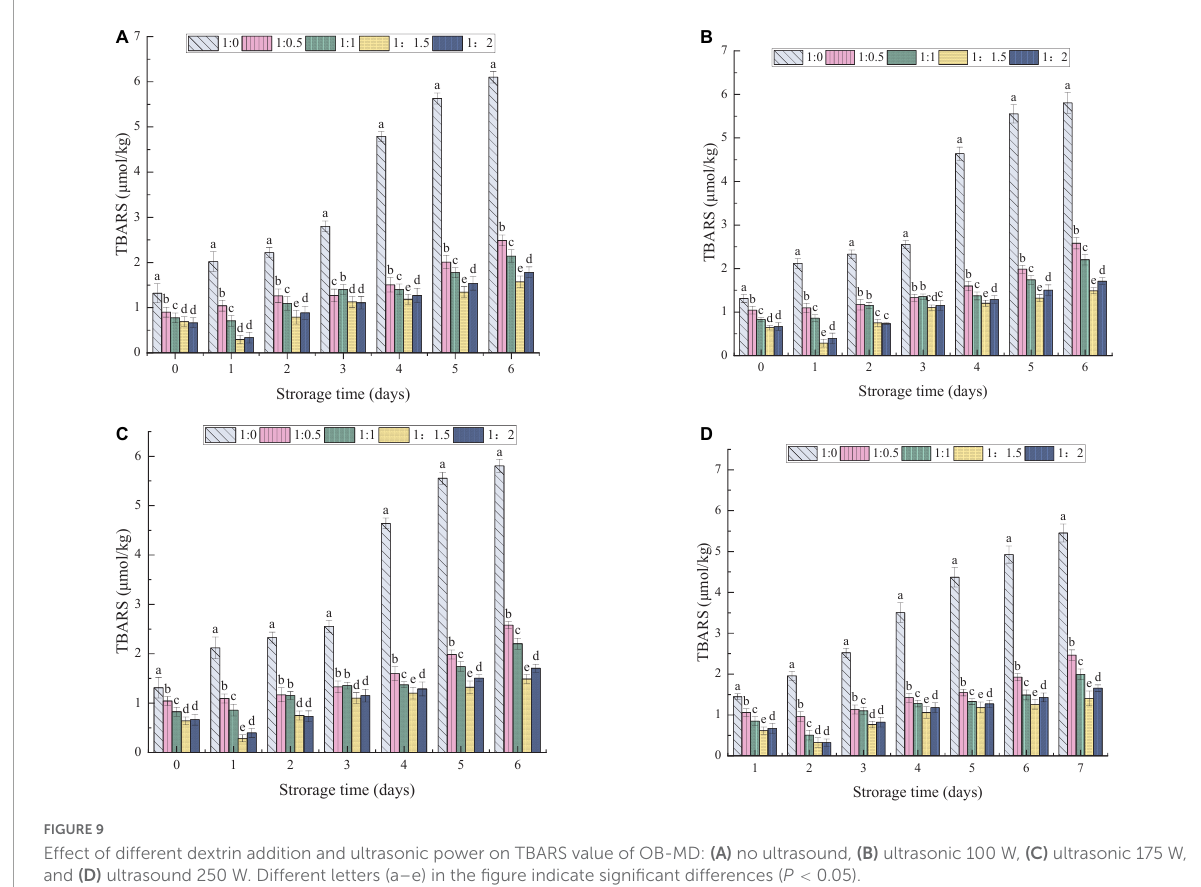
FIGURE10 Formation mechanism of MD-embedded soybean OBs induced by ultrasound.